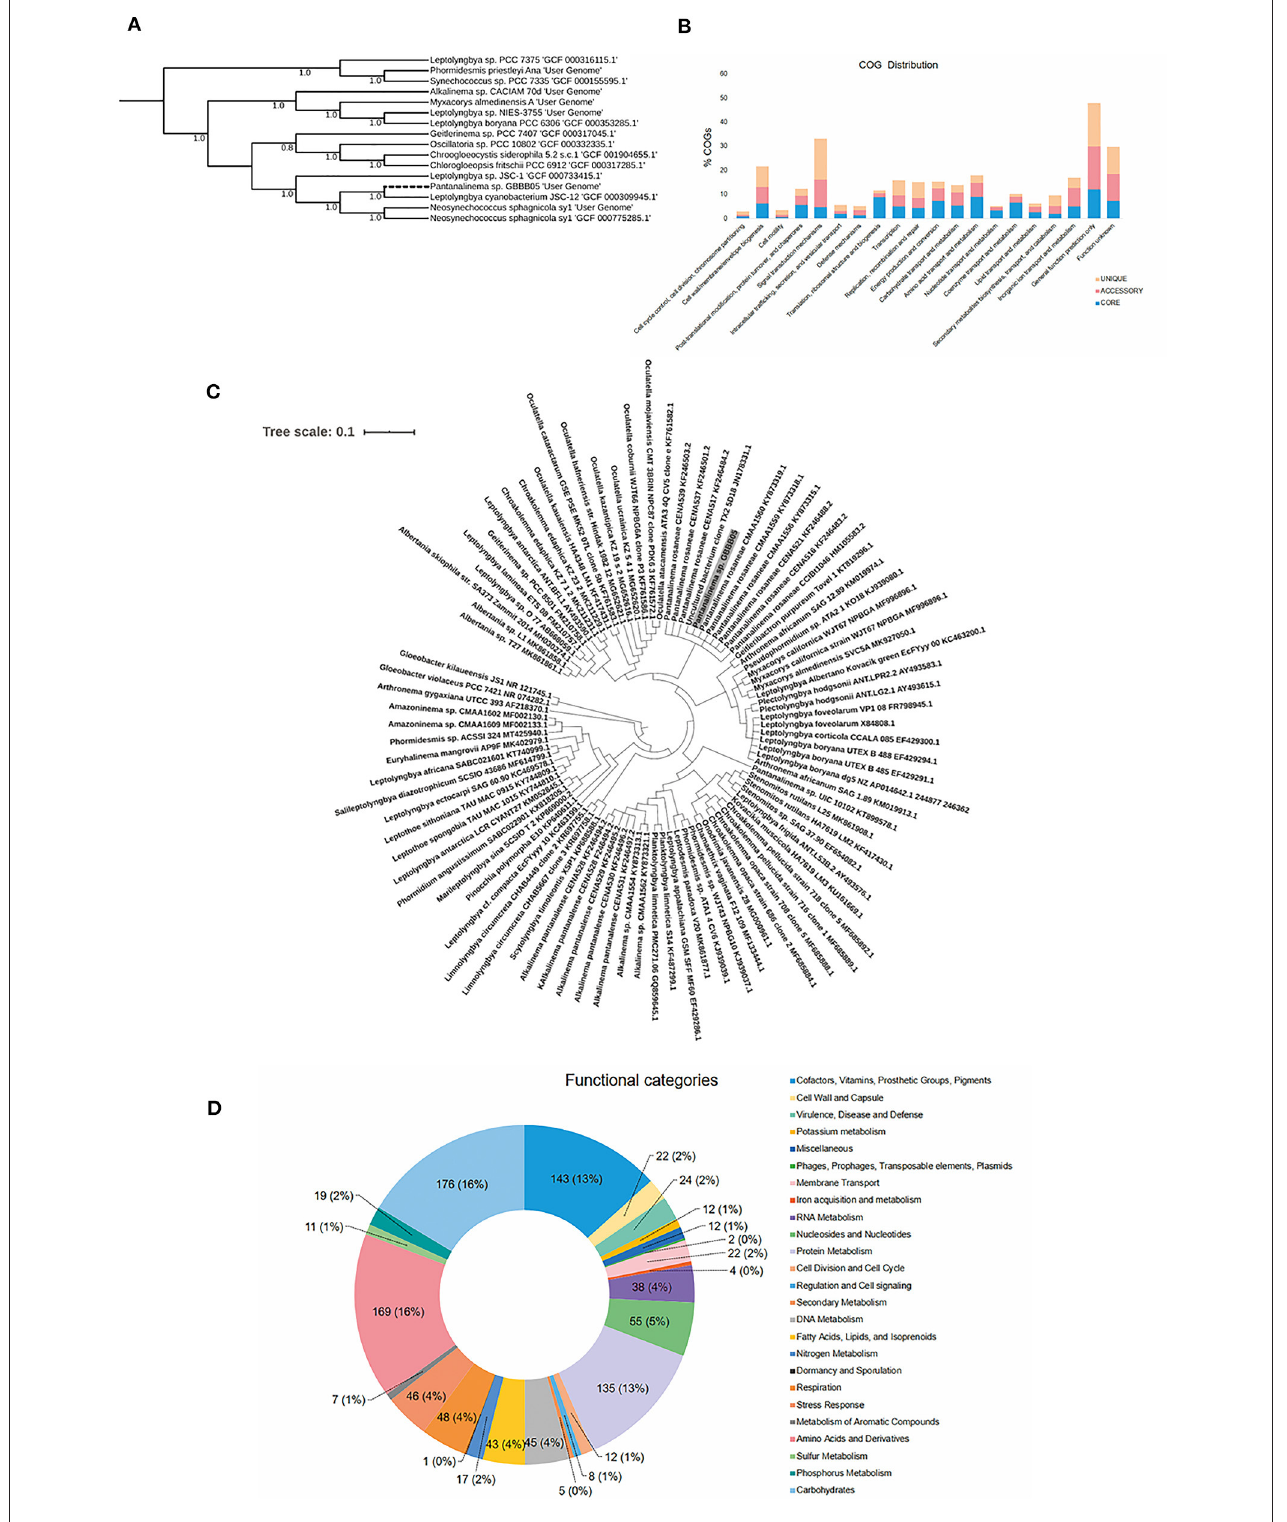
FIGURE 1 | (A) An approximately maximum-likelihood phylogenetic tree using a set of 49 core universal genes defined by COG (Clusters of Orthologous Groups) gene families on Phylogenetic Species Tree App based on closely related genomes selected from the public KBase genomes imported from NCBI-RefSeq.